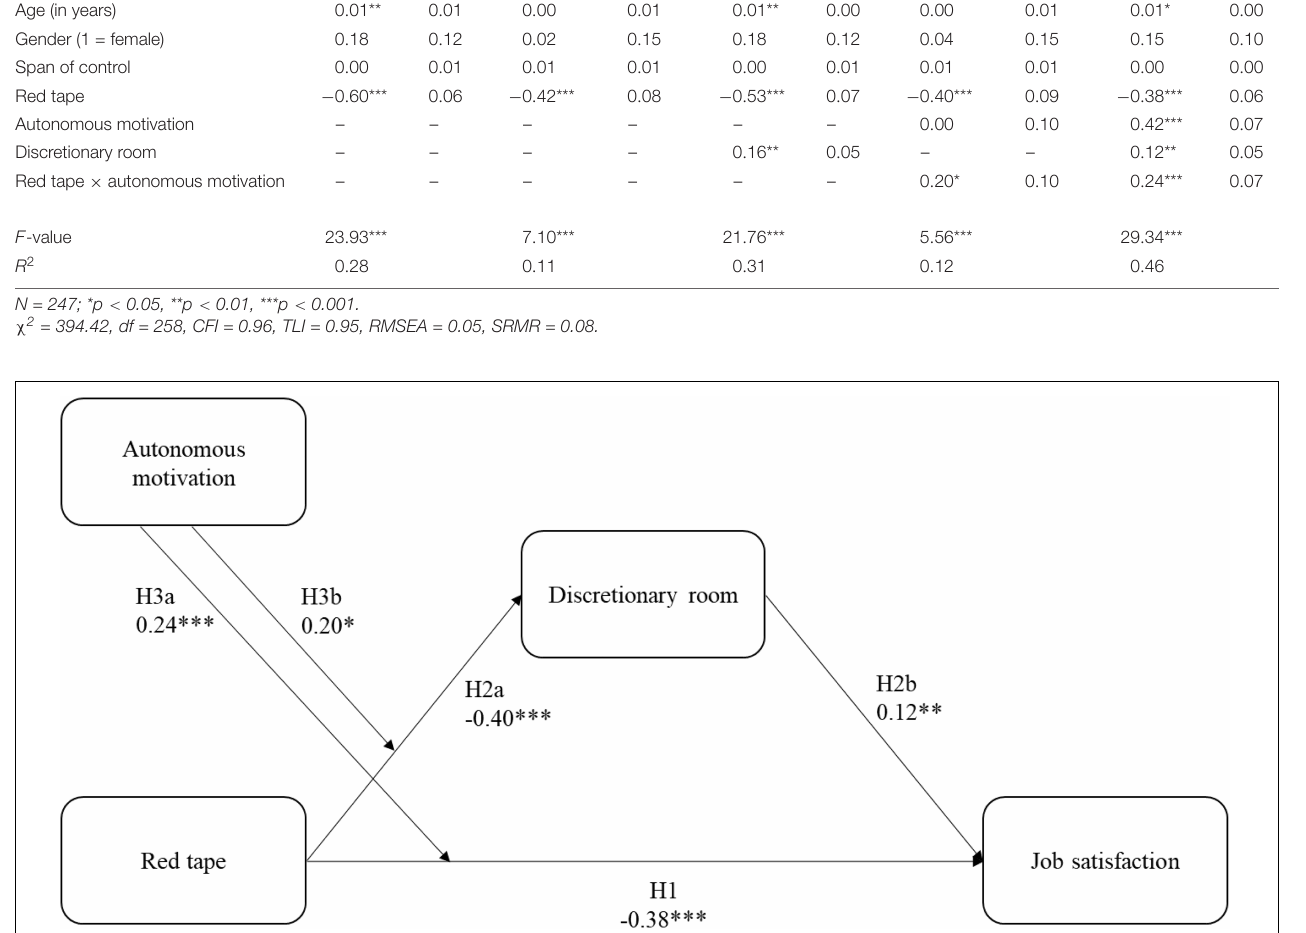
Frontiers in Psychology |